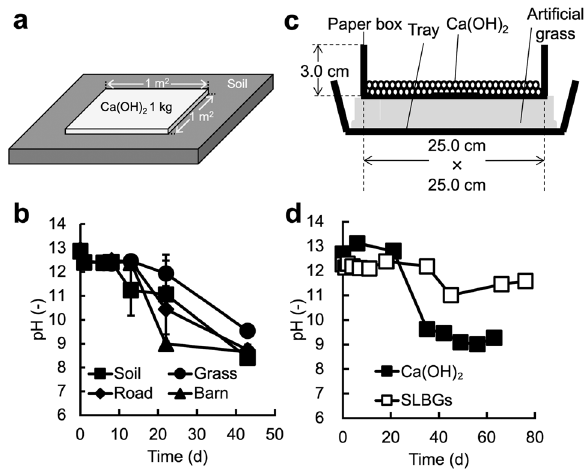
Figure 2. Evaluation of pH persistence under stand-by disinfection conditions. ( a ) Typical outdoor test. Ca(OH) 2 powder was spread at 1 kg/m 2 . ( b ) In the outdoor test, the change in pH after treatment with Ca(OH) 2 powder was evaluated on soil, grass, a road, and in front of a barn. ( c ) Schematic of the indoor test to measure the pH following disinfectant treatment. To mimic the outdoor conditions, this system consisted of a tray, artificial grass, and a paper box. For the treatments, disinfectants were placed in a paper box. Water (200 cm 3 / day) was applied, equal the annual precipitation in Hokkaido prefecture, Japan. ( d ) In the indoor test, the pH after treatment with Ca(OH) 2 powder or SLBGs was evaluated. Data represent the mean from three separate experiments. Error bars show the standard